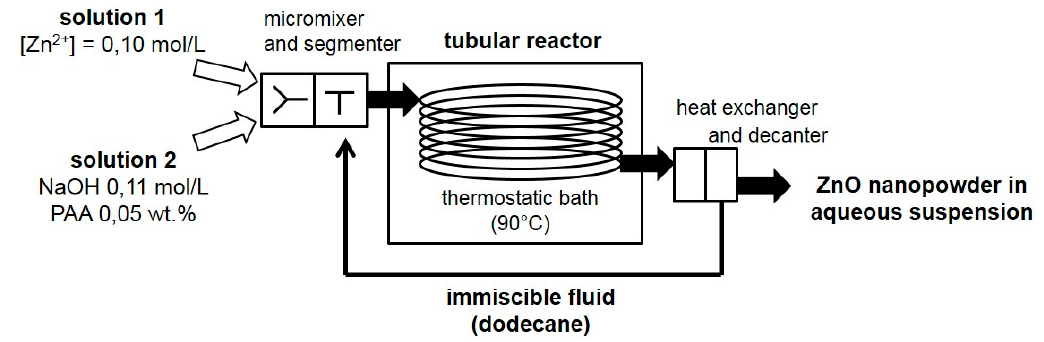
Figure 1. Schematic view of the Segmented Flow Tubular Reactor (SFTR).